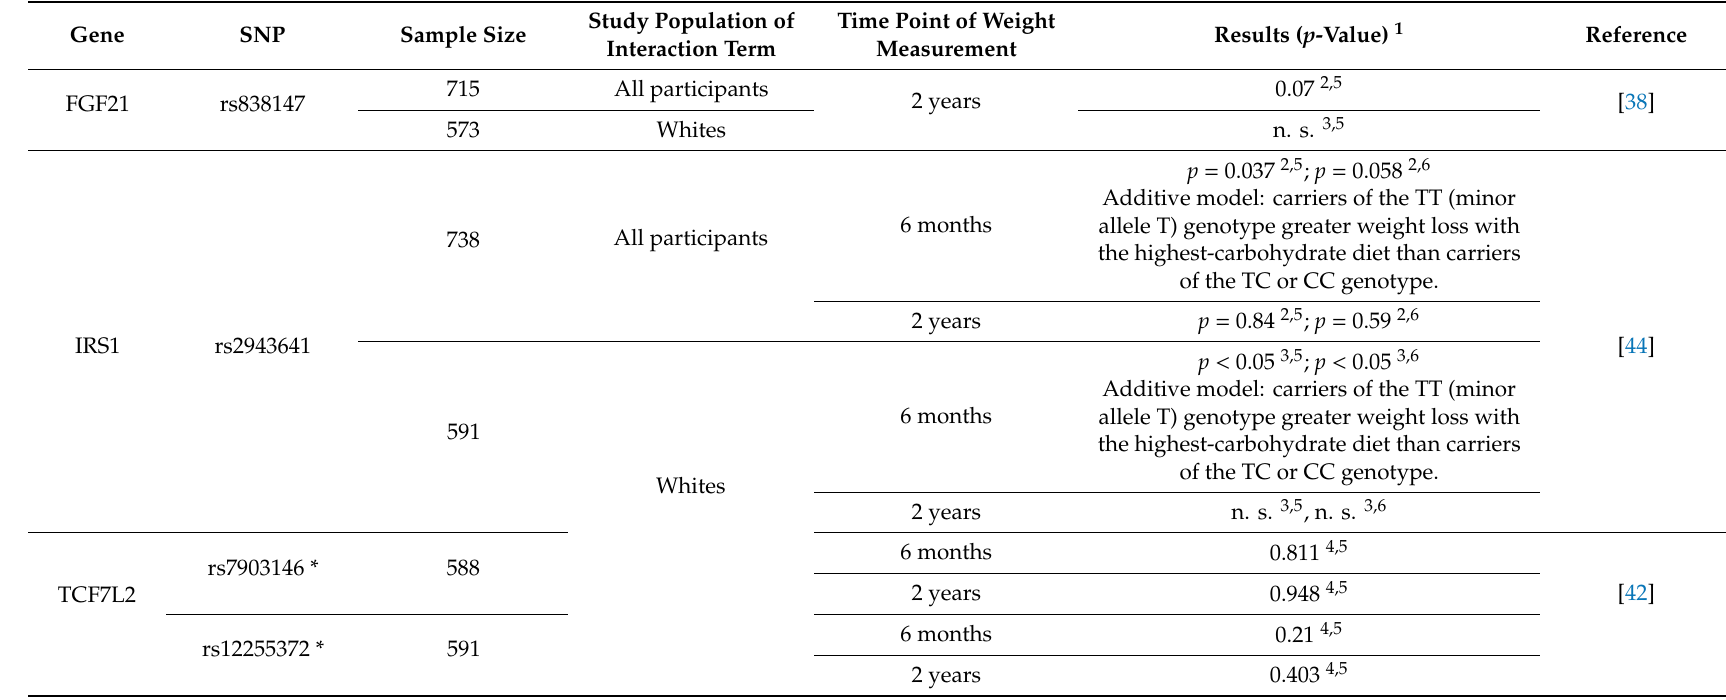
Table 3. Interaction of genotype and carbohydrate intake on weight